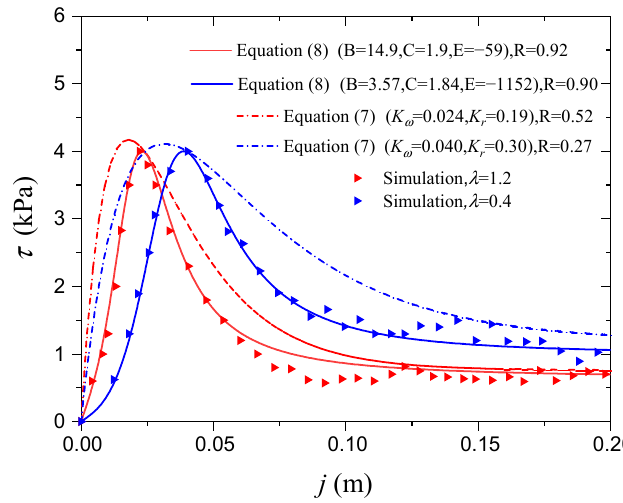
Figure 9. Fitting numerical test result.